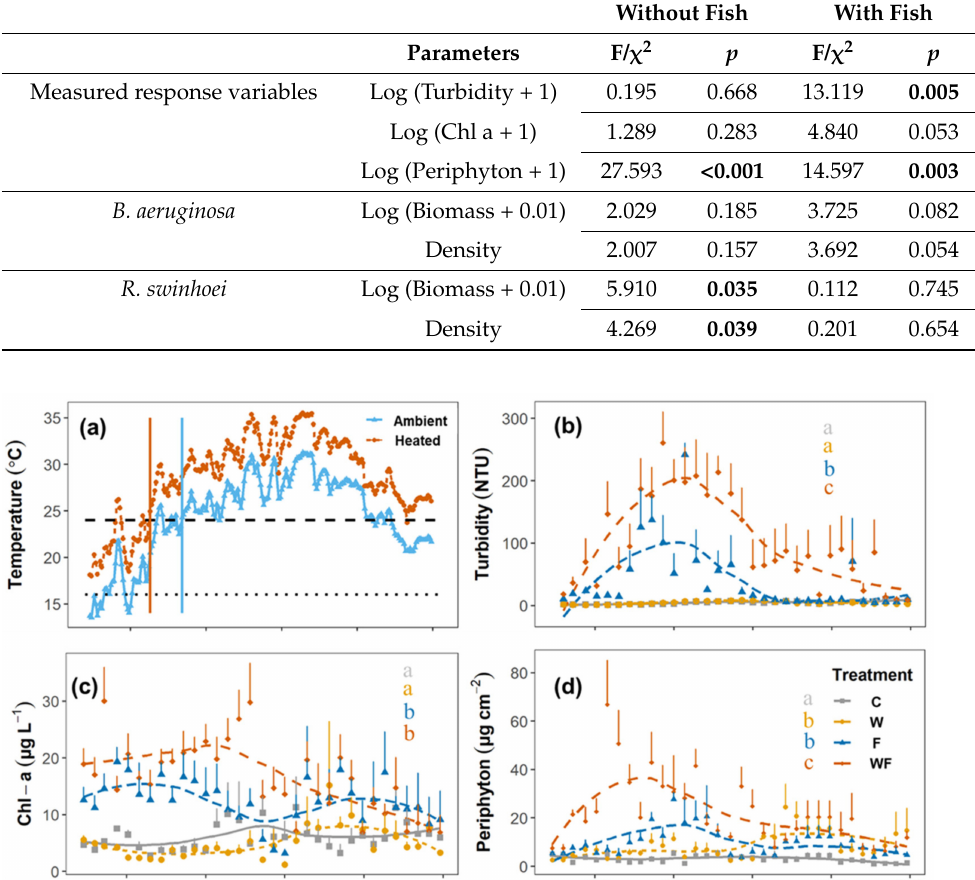
Table 1. Effects of warming on the measured response variables and snail biomass and density in two systems (without/with fish). Water turbidity, Chl-a concentration of the water column and periphyton, and snail biomass were analyzed using linear mixed-effects models, and snail densities were analyzed with generalized linear mixed-effects models and a Poisson link function. Bold number indicates significance < 0.05.